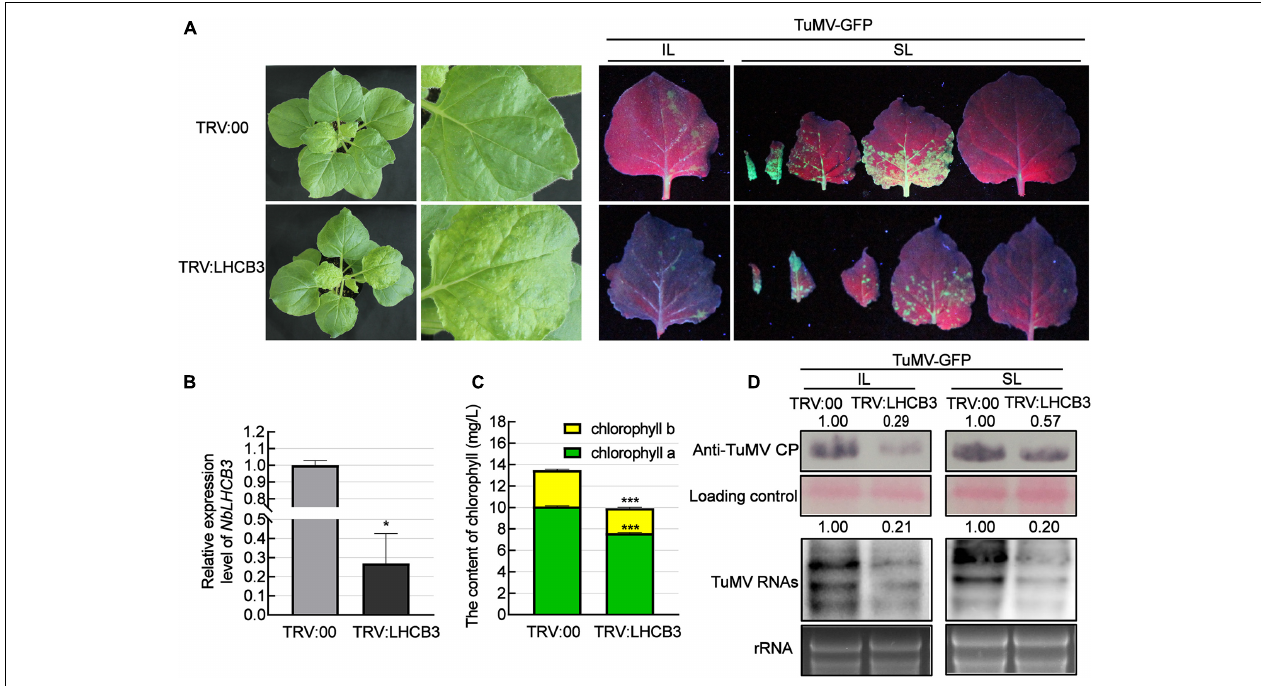
FIGURE 2 | Silencing of NbLHCB3 inhibited the infection of TuMV in N. benthamiana . (A) The phenotype of plants inoculated with TRV:LHCB3 or TRV:00 (Left). Examples of LHCB3-silenced and control plants mechanically inoculated with TuMV-GFP at 12 dpi and photographed at 4 dpi under UV light (Right). Systemically infected leaves (SL) at the corresponding location on both plants were collected for monitoring under UV. (B) Relative expression level of NbLHCB3 in the NbLHCB3 -silenced plants. (C) The chlorophyll contents [measured as described before (Yang et al., 2020)] were reduced in the NbLHCB3 -silenced plants. (D) Detection of TuMV RNAs and CP protein accumulation in plants inoculated with TRV:LHCB3 or TRV:00 at 4 dpi. Polyclonal antibody to TuMV CP and a CP probe tagged with DIG were used for analysis. Bars represent the standard errors of the means from three biological repeats. The relative intensity of the blot signal quantified by IMAGE J software is shown on the lanes. A two-sample unequal variance directional Student’s t -test was used to test the significance of the differences (* P < 0.05; *** P < 0.001).